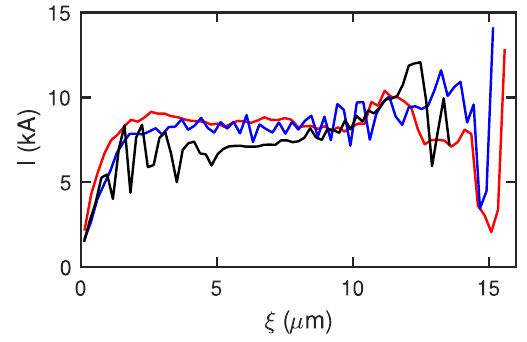
FIG. 5. Current profile of the injected beam. The ramp parameters are the same as those in Fig. 4. The red, blue, and black lines correspond to ramp length of 5, 10, and 25 c= ω p ,